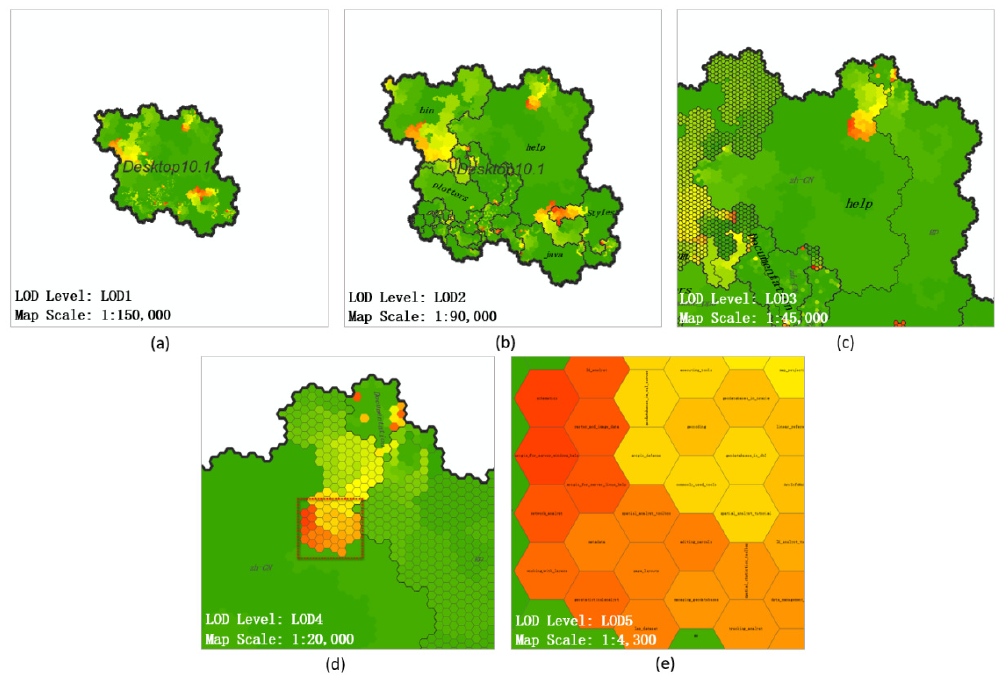
Figure 15. The multilevel search and location of large file communities: ( a ) Map scene of LOD1; ( b ) Map scene of LOD2; ( c ) Map scene of LOD3 ( d ) Map scene of LOD4; ( e ) Map scene of LOD5.